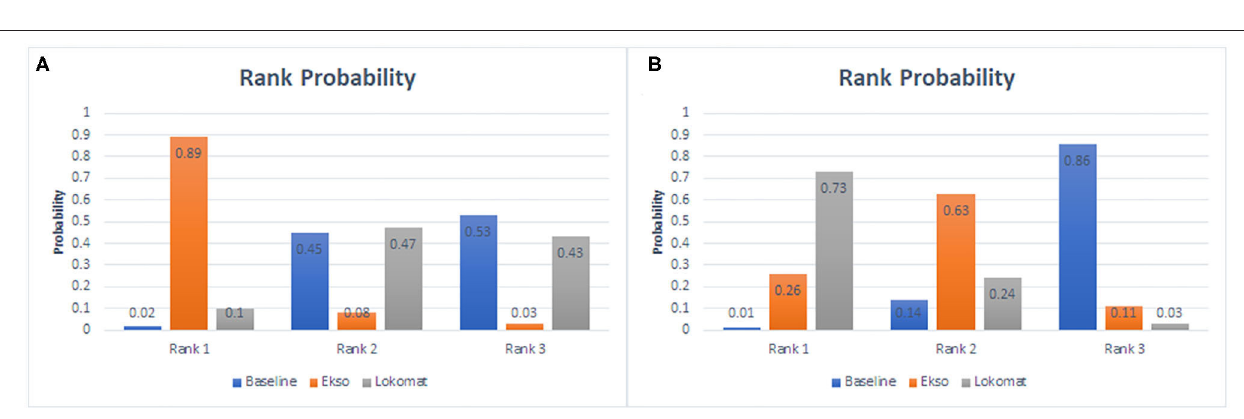
FIGURE 7 | Rank probability of each target strategy by the improvement of wearable EAW and Lokomat on 10-MWT speed (A) and the improvement of wearable EAW and Lokomat in the WISCI-II scores (B)